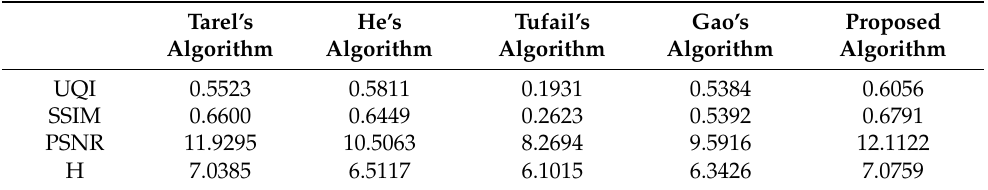
Table 2. Objective evaluation results on the second group of defogged images based on five defogging algorithms.